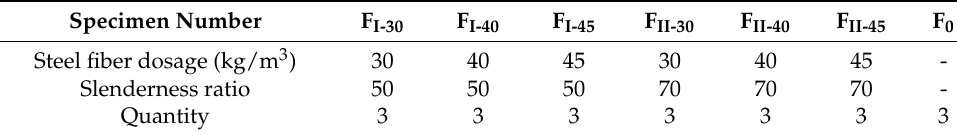
Table 3. Grouping and numbering of specimens under normal temperature conditions.